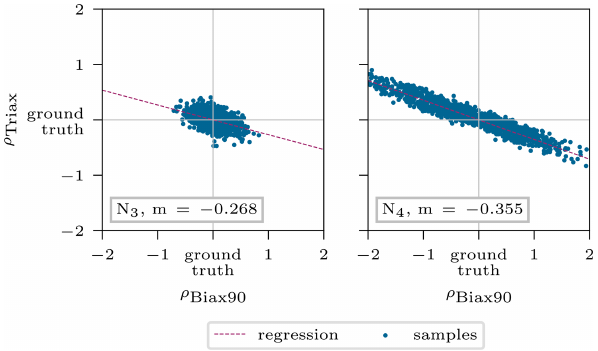
Figure 12. Interaction of shear stiffness G 12 , Biax90 and G 12 , Triax describing the intrinsic model ambiguities. The depicted values correspond to the standardized mean posterior prediction for the 5000 test samples.